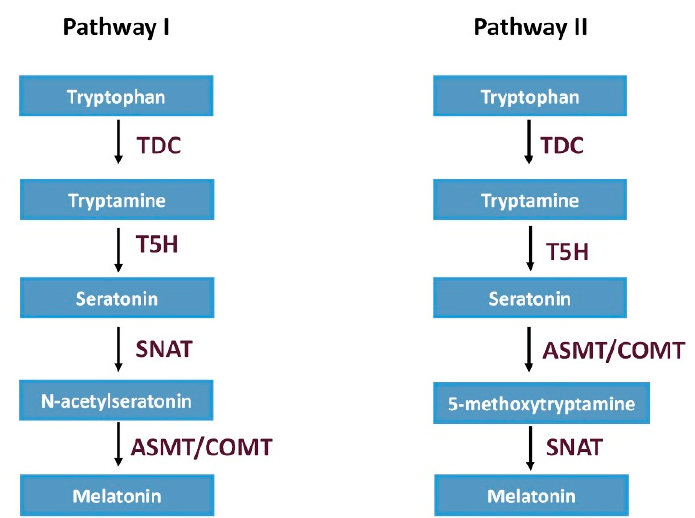
Figure 2. Melatonin biosynthesis pathways in